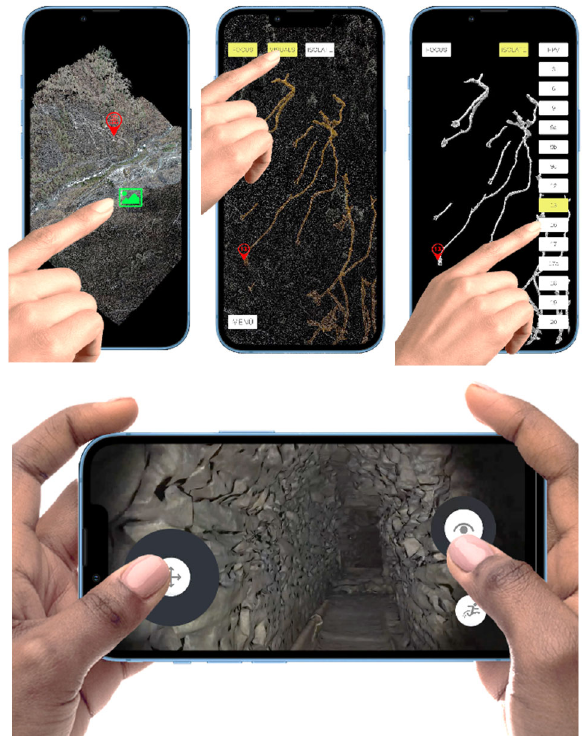
Figure 12. Interaction with the demo mobile application. The app